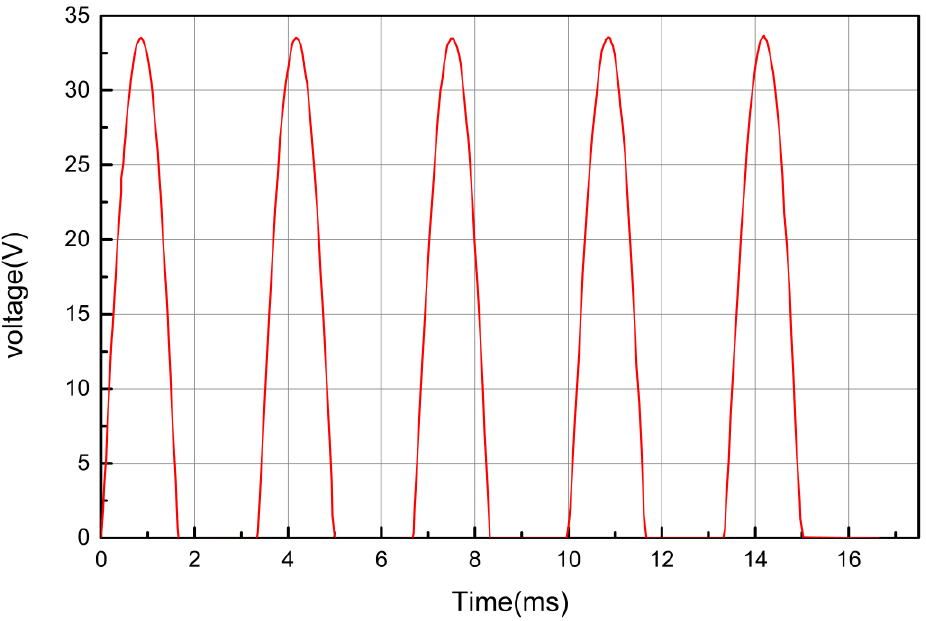
Figure 11. Output voltage waveform at 4000 r/min and 300 W.